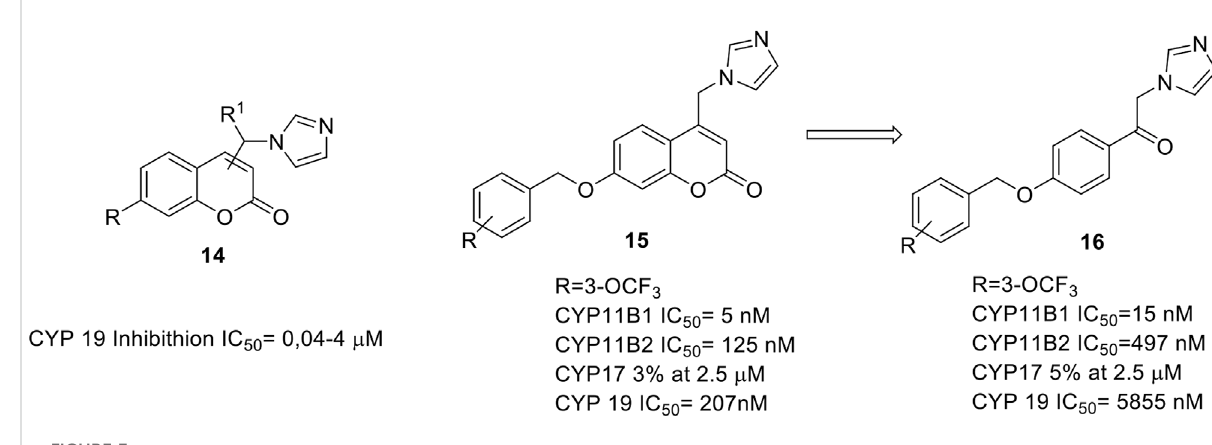
FIGURE 3 General structure of aromatase inhibitors. (Stefanachi et al., 2011; Stefanachi et al.,